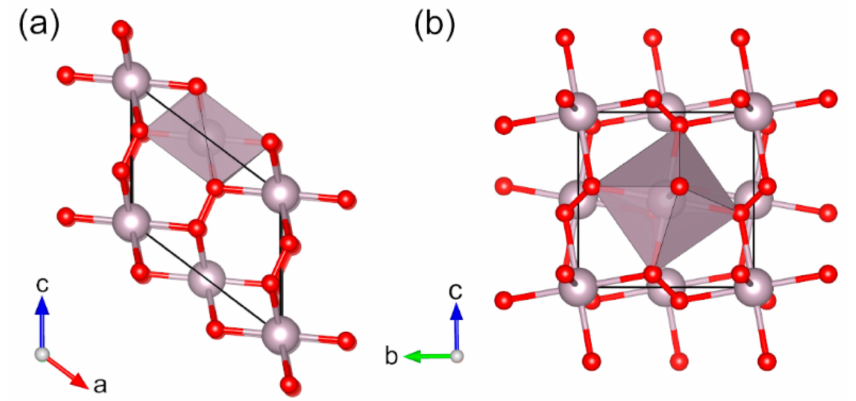
Figure 11. Optimized structures of ( a ) α -HgO 2 ( mS 6) and ( b ) β -HgO 2 ( oP 12) (red: oxygen, almond: mercury). Coordination octahedra of Hg atoms are shown in almond